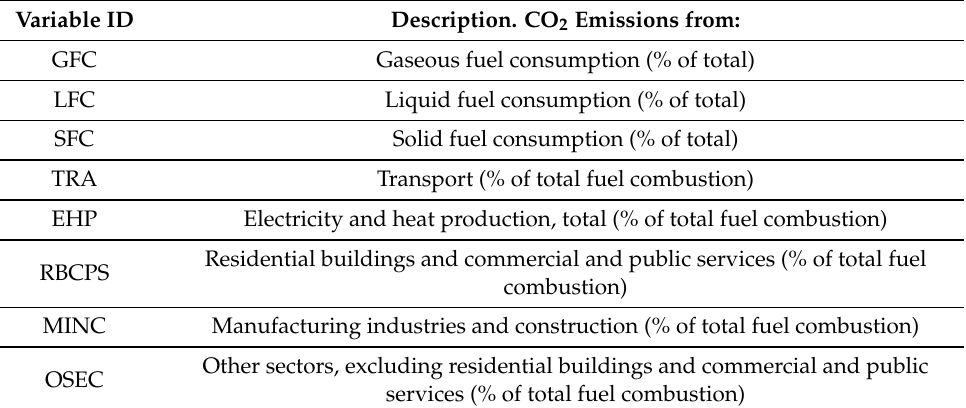
Table 1. Variable